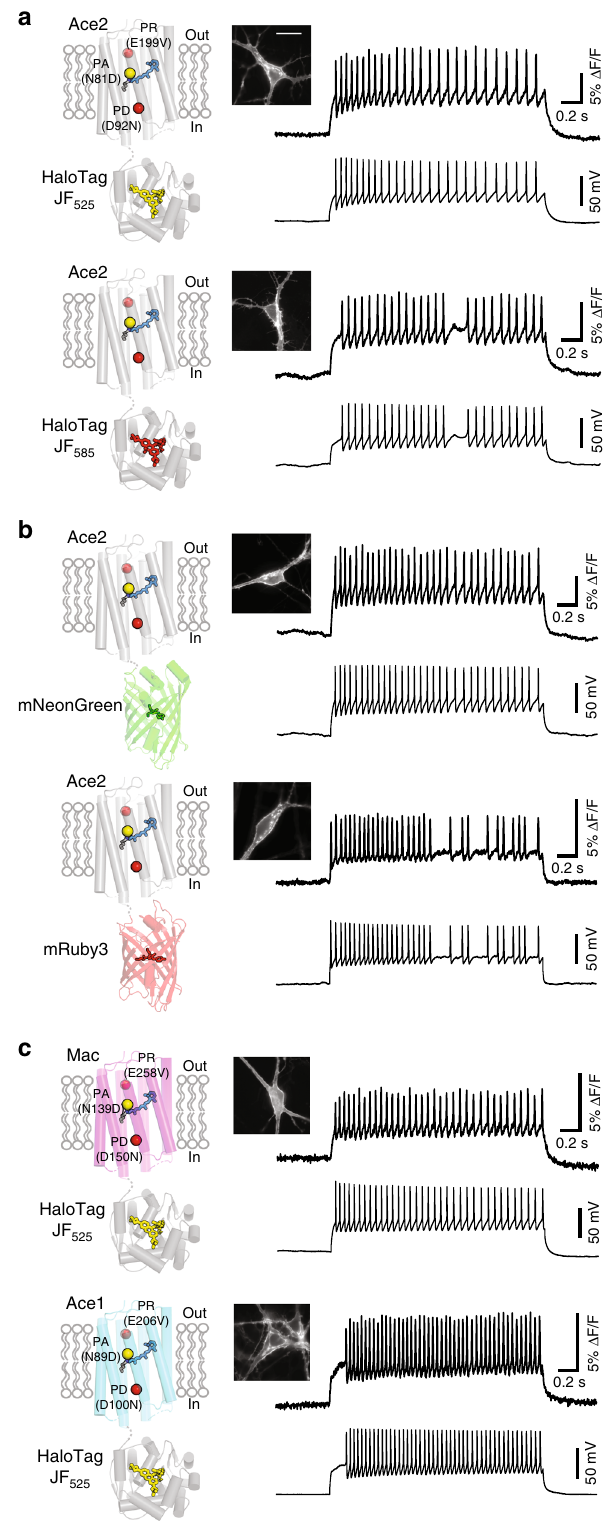
labeled with a yellow dye (JF 525 ) or a red dye (JF 585 ) (Fig. 3a). We